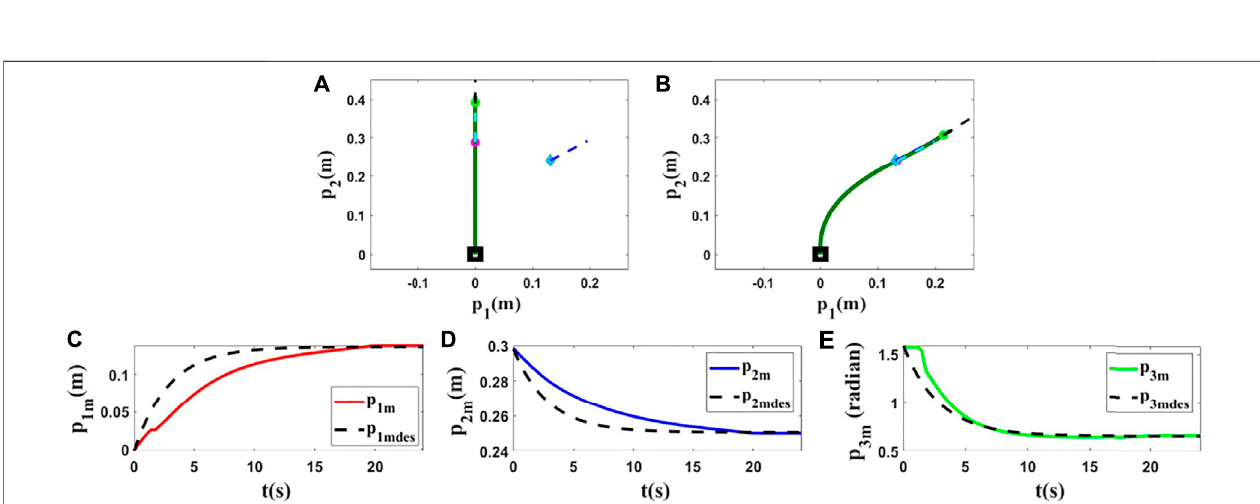
FIGURE8| Simulation 6.Firstrow: (A) and (B) aretheinitialand fi nalshapeoftheobject,respectively.Thedesiredstateofthepoint m isshown asabluediamond (position) and a dashed line segment (orientation). L = 0.43( m ), M 0 = [0.0000, 0.3000, 1.5708] T , and M fdes = [0.1400, 0.2500, 0.6650] T . After applying the proposed controllertothismodel,the fi nalstateofthecontrolledpointis[0.1415,0.2502,0.6673] T .Secondrow: (C) , (D) and (E) arethestatesofthecontrolledpointbasedonthe desired trajectories in the sixth simulation using the ARAP model.